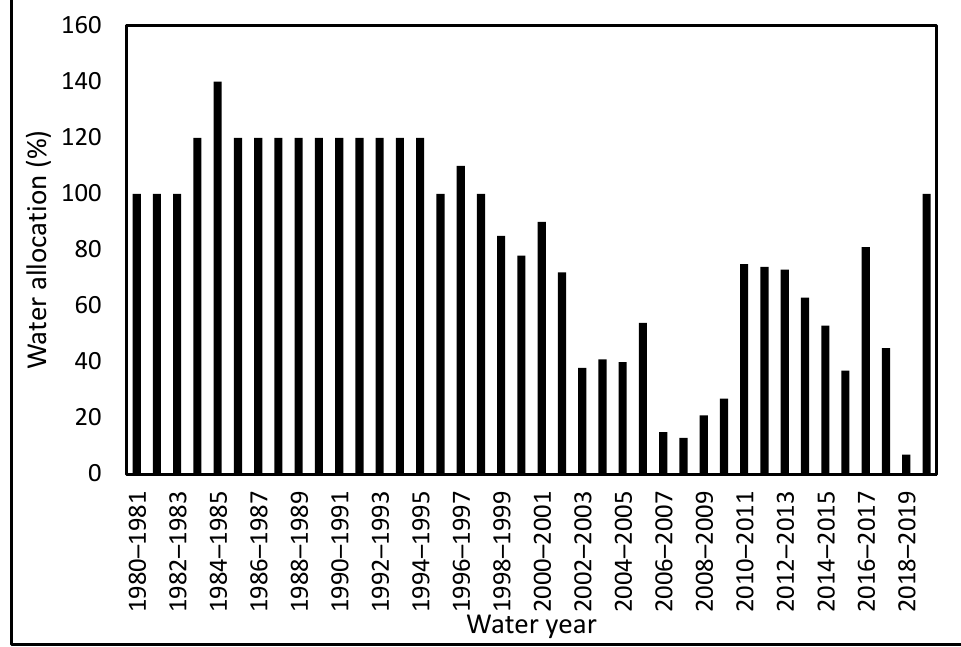
Figure 1. Historical annual percentage allocation of irrigation water entitlement in the Murrumbidgee Irrigation Area, Riverina, NSW (data from https://www.industry.nsw.gov.au/water/allocations-availability/water-accounting/historical-available-water-determination-data, accessed on 20 November 2021).